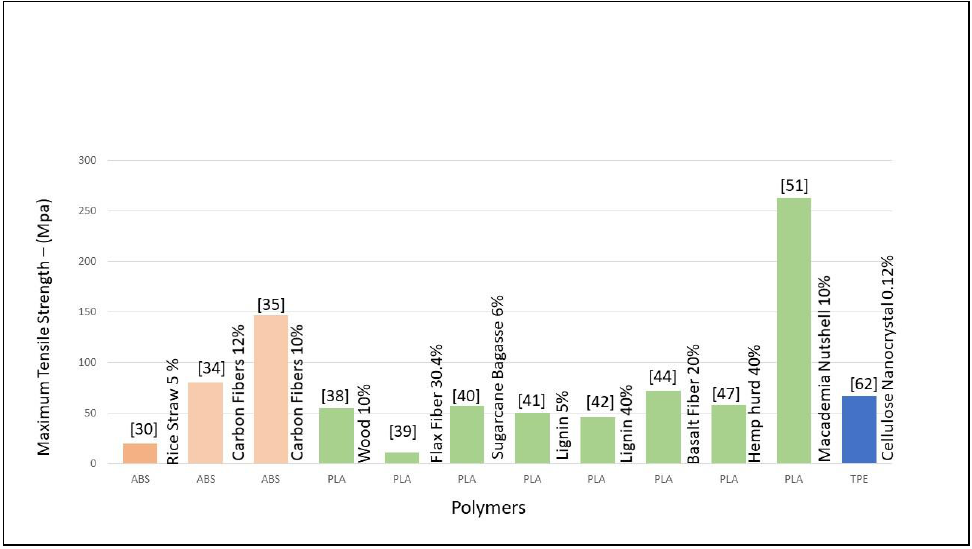
Figure 2. The cycle of 3D printing using natural fibers.